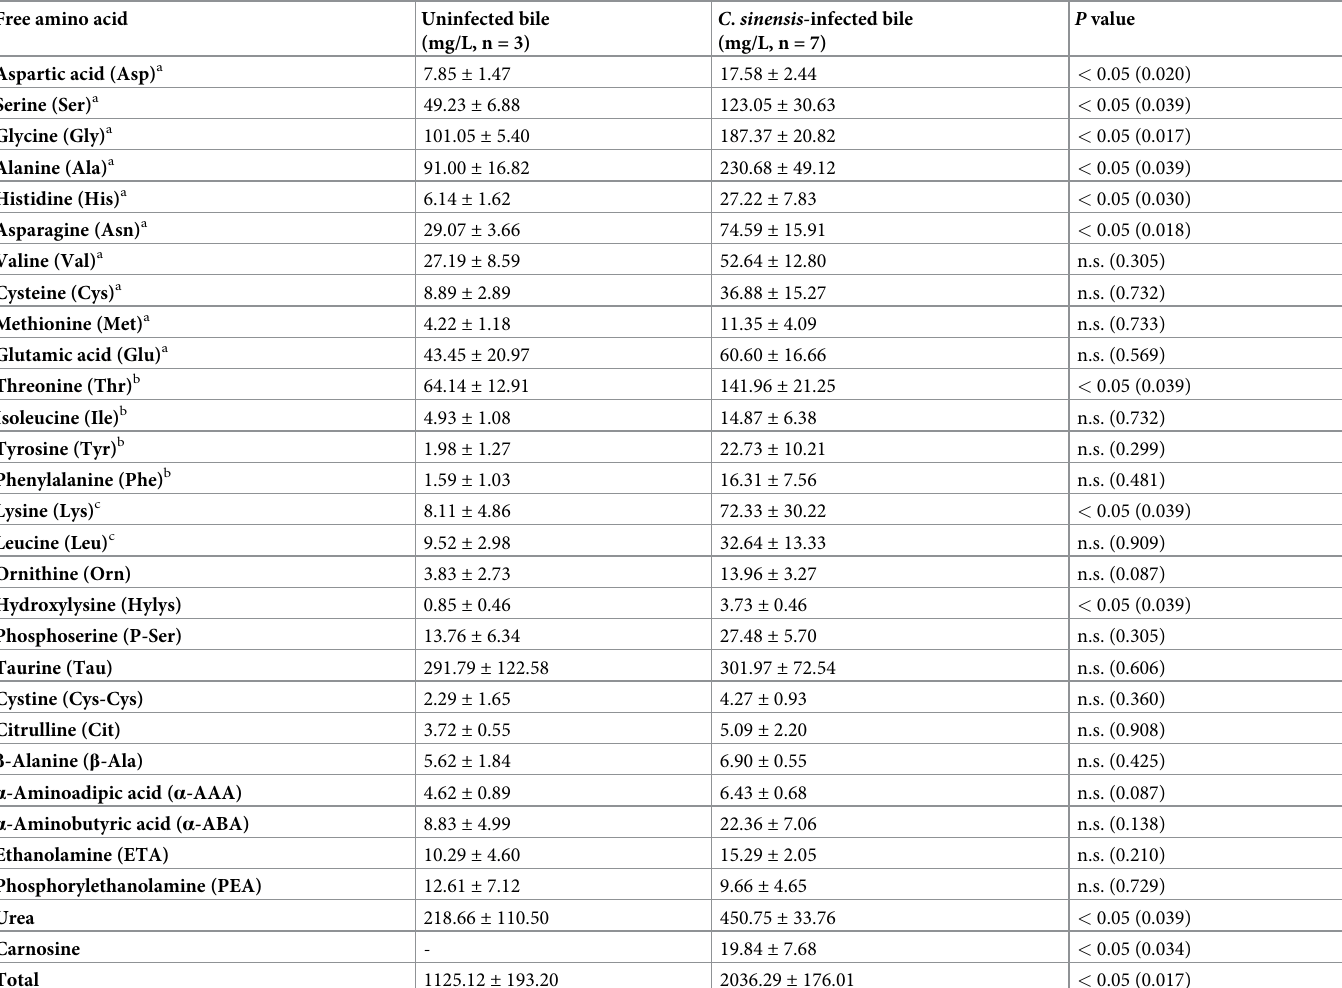
Table 1. Comparison of free amino acids between C . sinensis -infected and uninfected bile. Free amino acid